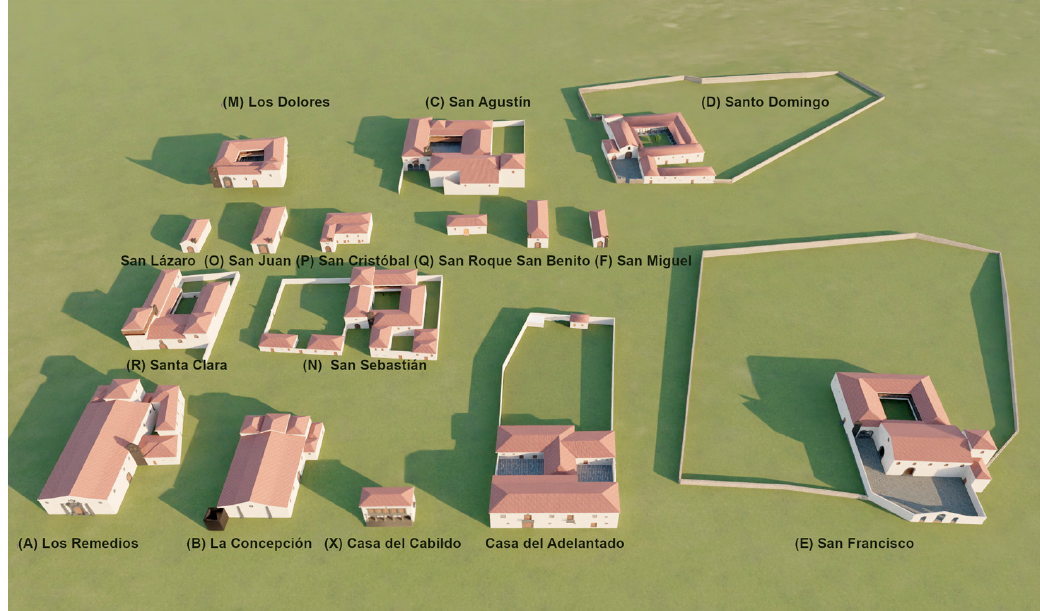
Figure 17. 3D models of singular buildings.